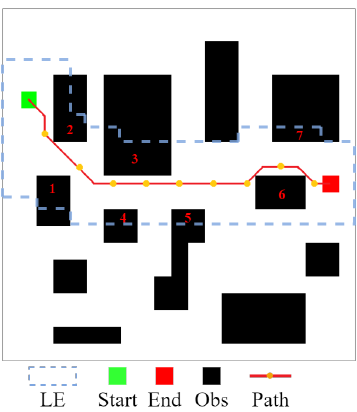
Figure 9. Obstacle information of the CLSQL